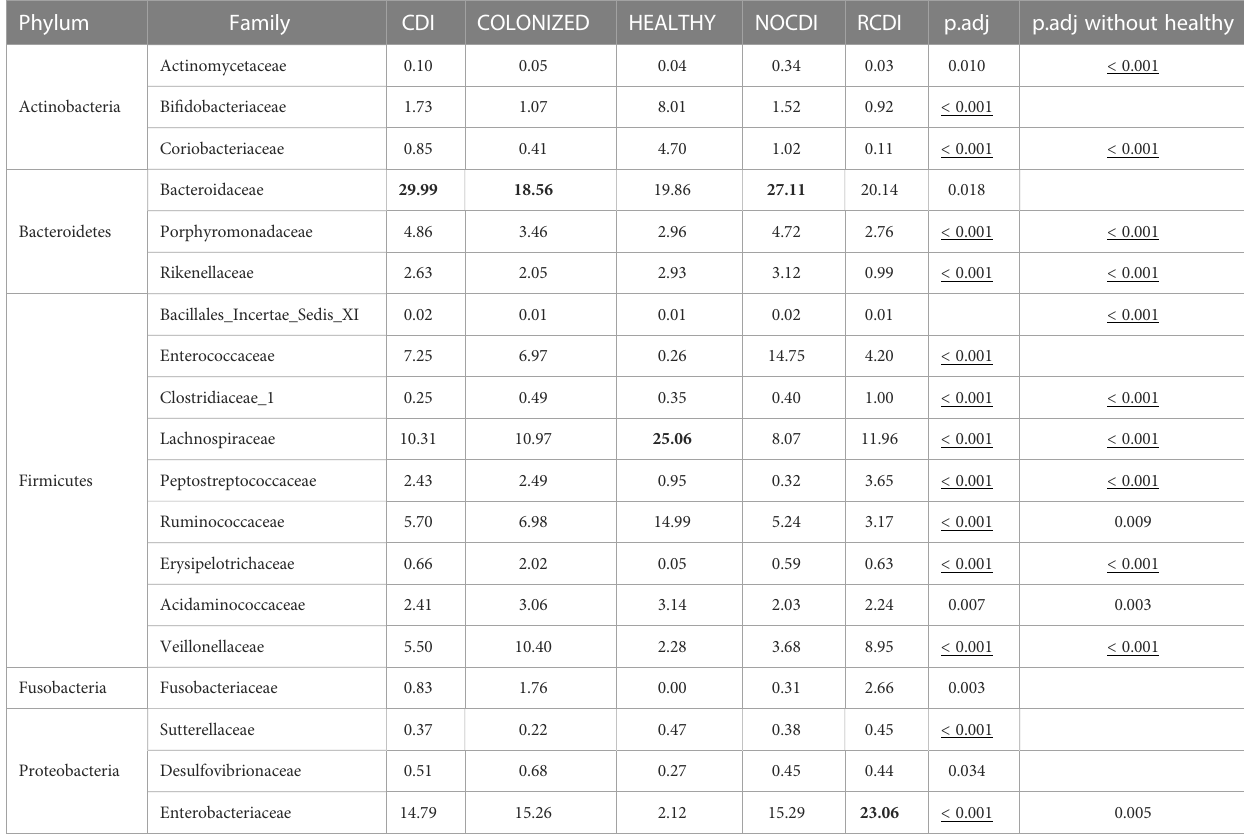
TABLE 5 Mean relative abundance (%) in each group at family level.